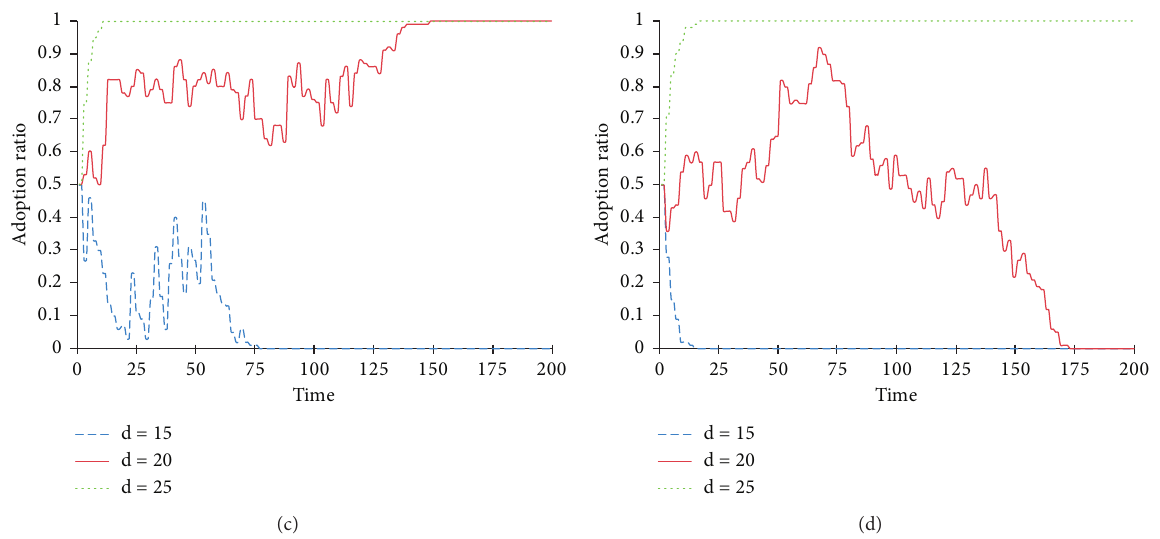
Figure 10: Influence of betrayal punishment on product diffusion. (a) No overconfidence model. (b) Benefit and cost overconfidence model. (c) Benefit overconfidence model. (d) Cost overconfidence